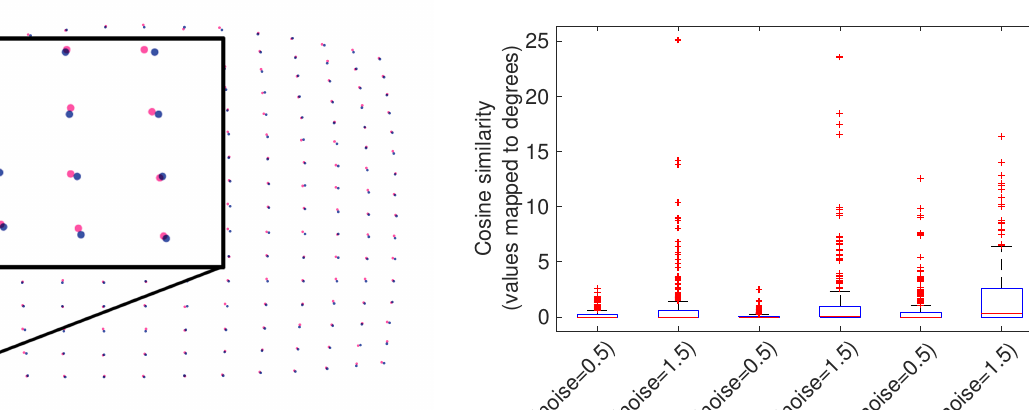
Figure 18 . Pupil centers in the eye image corresponding to a grid of 16 × 16 fixation points on the calibration plane, are shown by red for noisy condition, and blue for without noise. Image resolution is 1280 ×